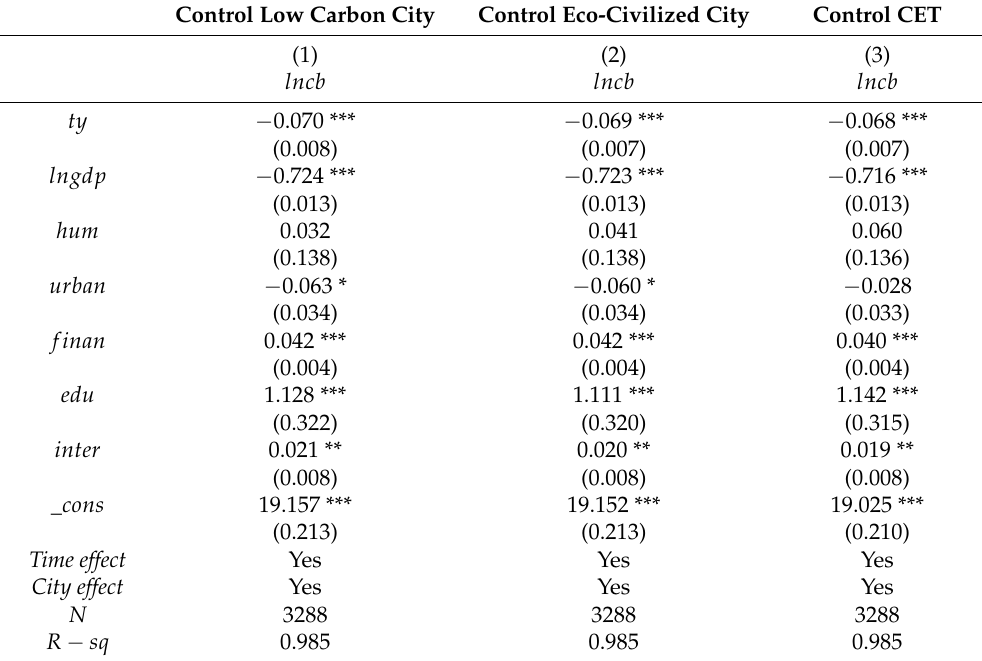
Table 6. Control other